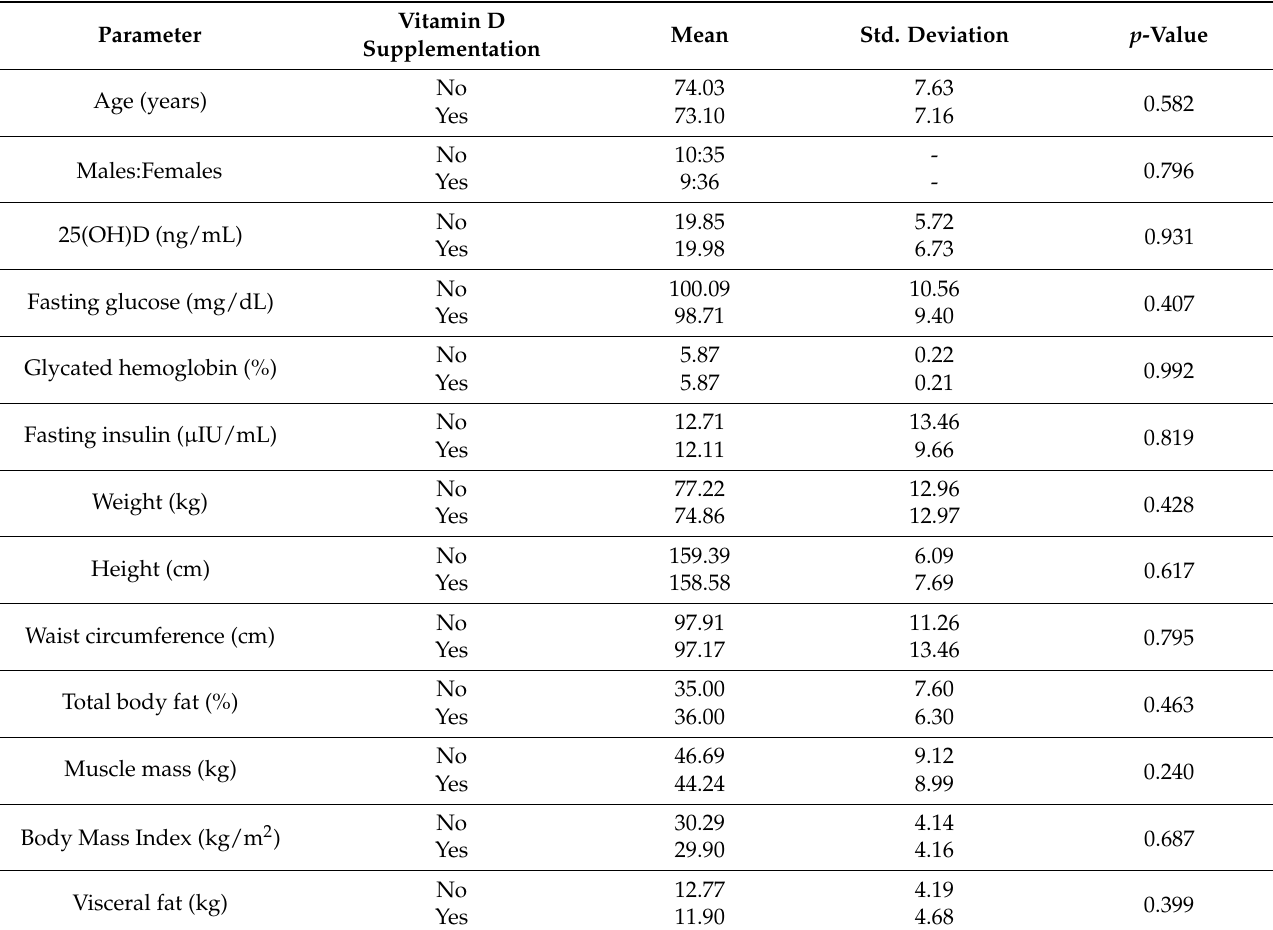
Table 1. Baseline demographic, laboratory, and anthropometric features of the two